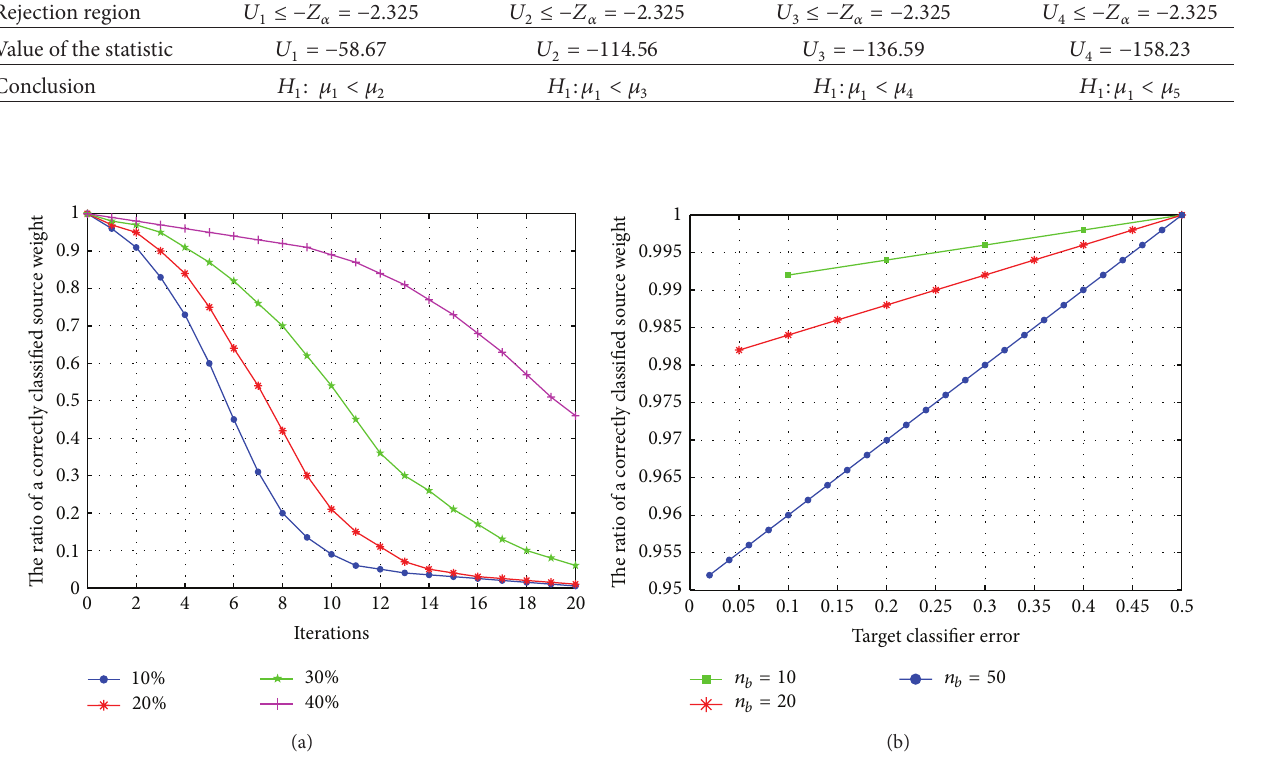
Figure 4: (a) Results for 20 iterations with different target error rates. (b) Results after a single iteration with different number of target